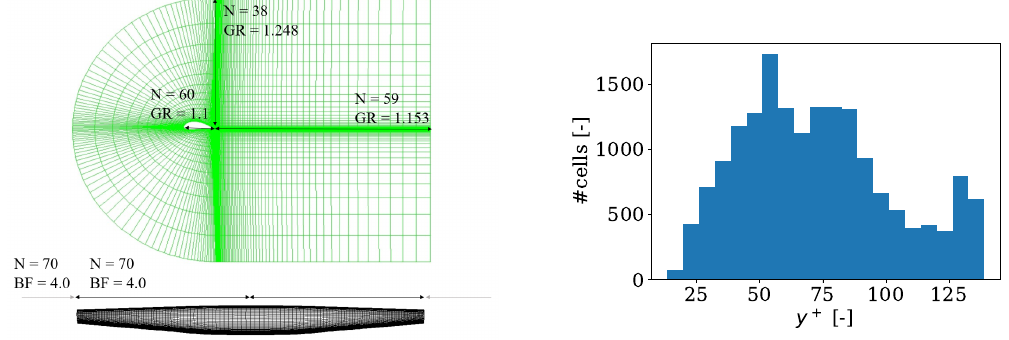
Figure 8. ( left ) Division of cells and growth rate (N = number of divisions, GR = growth rate, BF = bias factor). ( right ) Histogram of y + values (flight speed of 80 m/s, α = 0°). Chimera/overset technique : Separate meshes are developed to simulate the flow close to the wing (in the component mesh) and in the far-field wind flow (in the background mesh). The wing component mesh moves through the stationary background mesh according to the prescribed flight path. The Chimera/overset technique couples the two meshes at the intersection, the overset boundary, by interpolating the overlapping cells. This interpolation is updated while solving the flow equations. The meshes are constructed to have similar cell sizes ( ∼ 4 m) at the overset boundary to ensure good connectivity. The overset cell types are indicated in Figure 9. The cells in green are not used for interpolation and are directly solved by the RANS solver. The cells indicated in red are donor cells. The solution of these cells is passed to the blue cells, the receptor cells (of the other mesh). Both meshes have donor and receptor cells. In Figure 9, the large red cells are the donor cells of the background mesh, which pass information to the blue receptor cells of the component mesh at the overset boundary. The inner blue cells are the receptor cells of the background mesh. These cells receive information from the donor cells of the component mesh, which are hidden below the blue receptor cells of the background